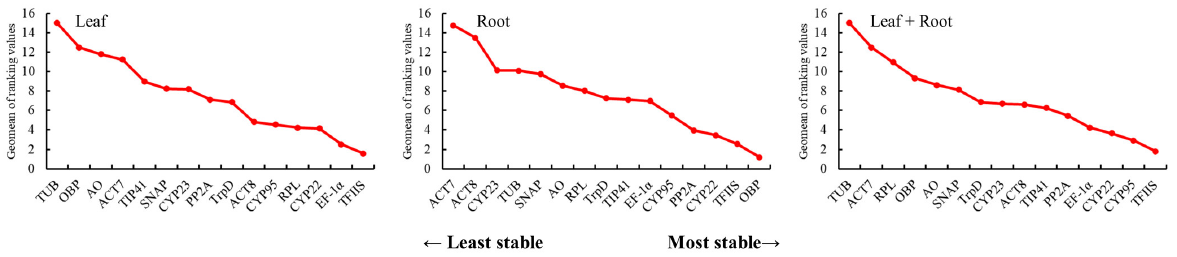
Figure 7. Ranking of candidate reference gene stability by RefFinder analysis.